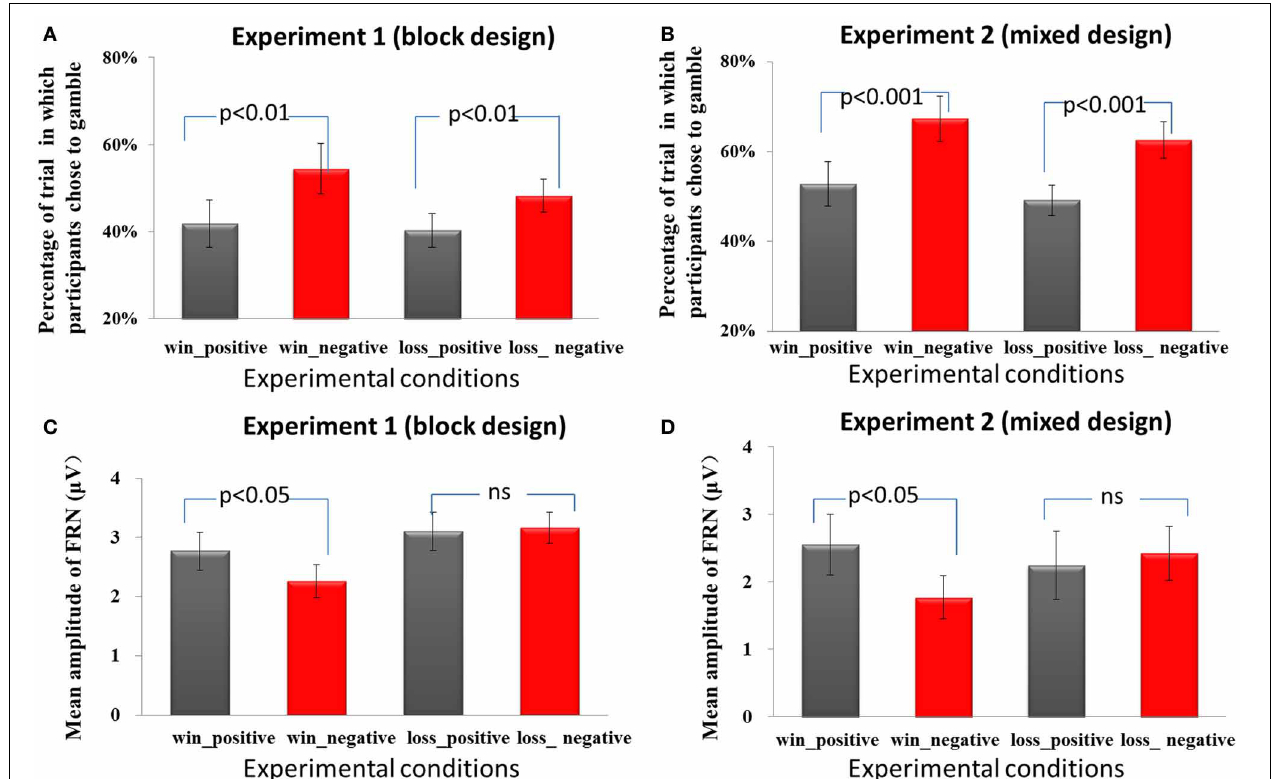
FIGURE 2 | Behavioral and ERP results. In Experiment 1 (A) and Experiment 2 (B) , the frequency of gamble choices (mean, SE) is significant higher in negative frame than in the positive frame,